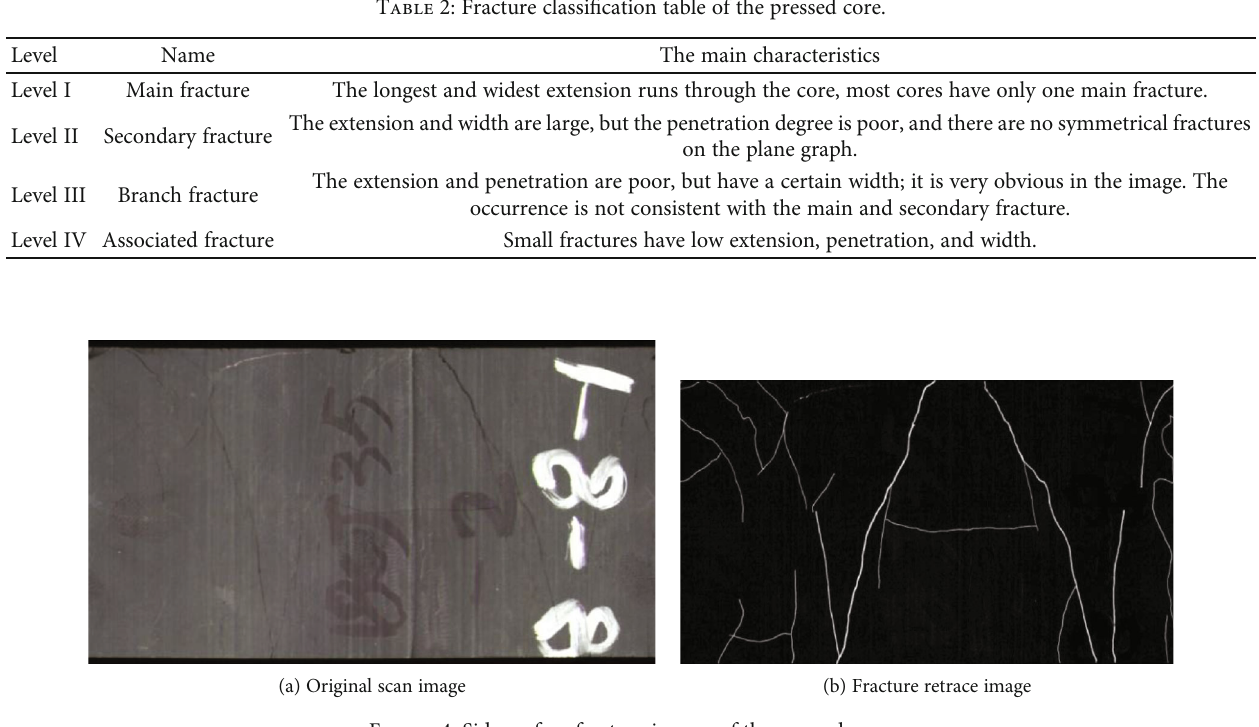
Figure 4: Side surface fracture images of the pressed core.